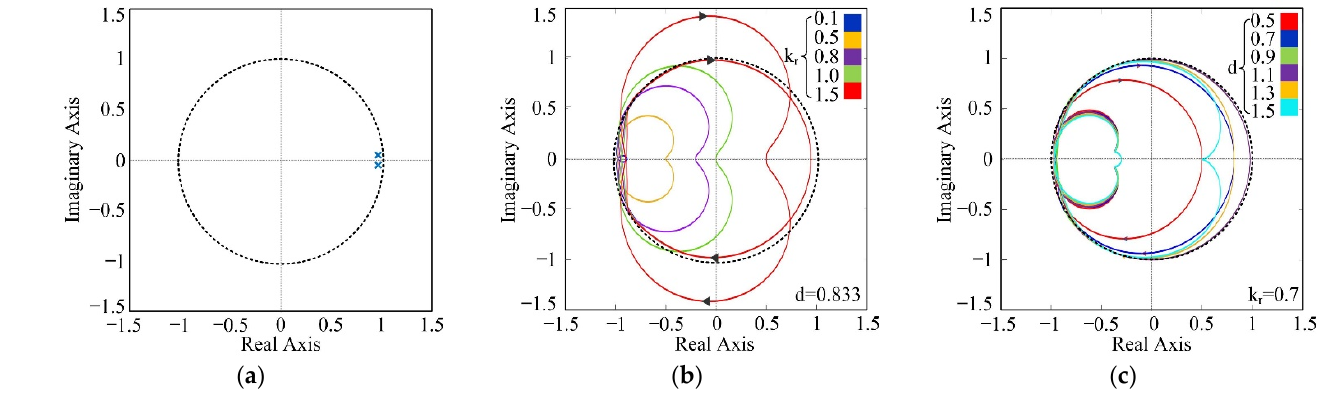
Figure 11. ( a ) Pole distribution of G m ( z ); ( b ) Nyquist diagrams of H ( z ) with different k r ; ( c ) Nyquist diagrams of H ( z ) with different d.